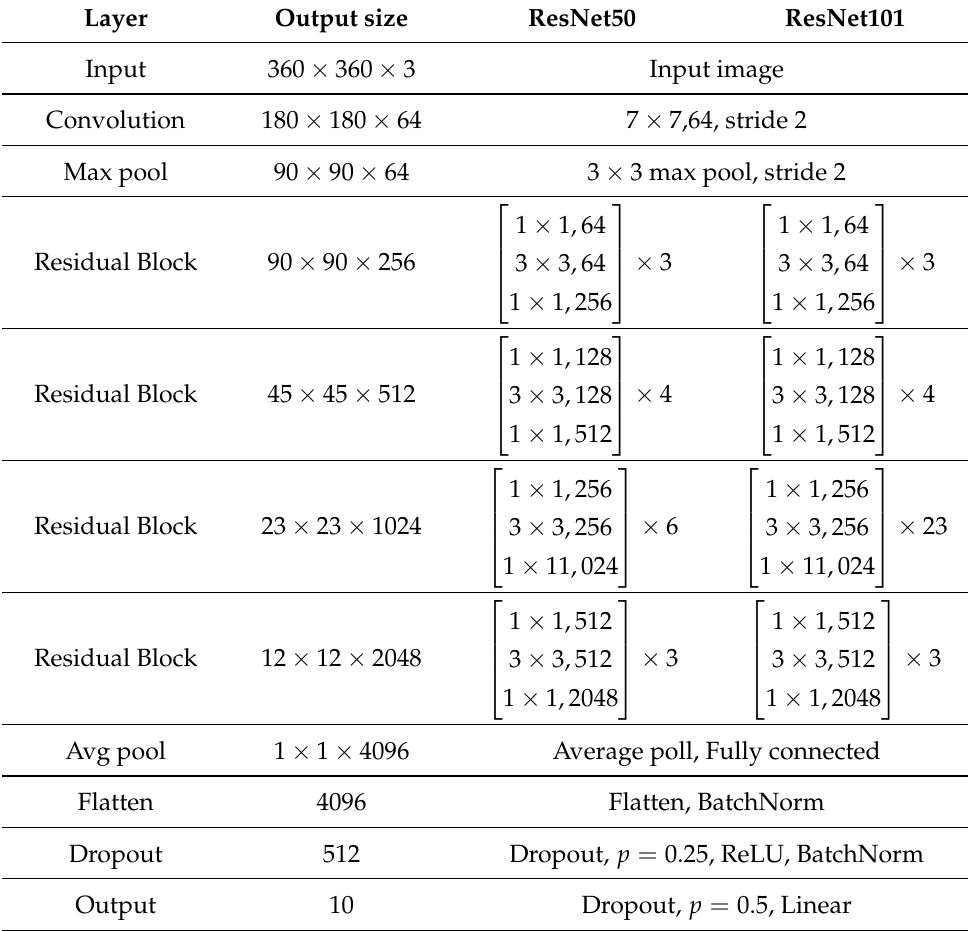
Table 1. ResNet50 and ResNet101 used in the proposed method, with resized input